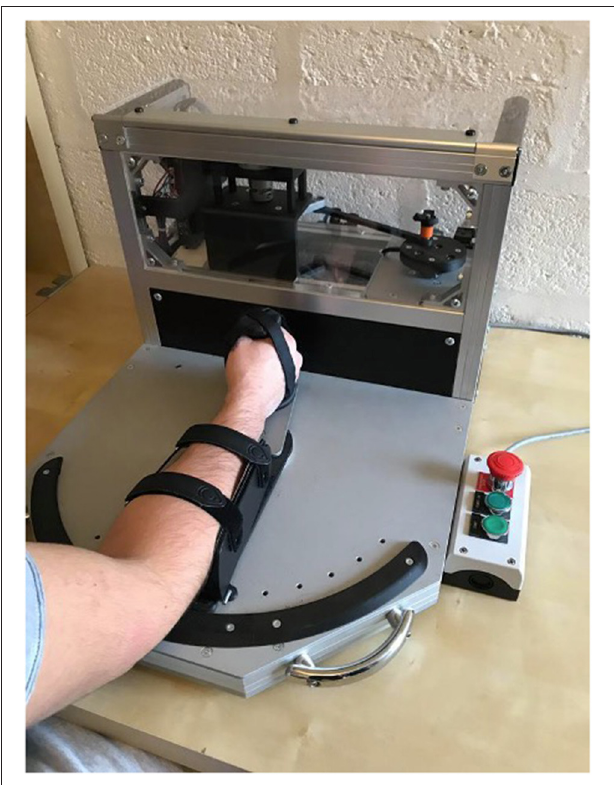
FIGURE 3 | Position of the wrist into the electromechanical oscillation device (EOD).